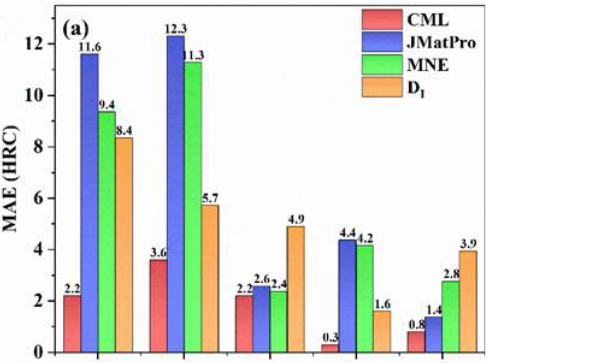
Figure 7. Flow chart of the CML model for predicting hardenability curves of non-boron steels.